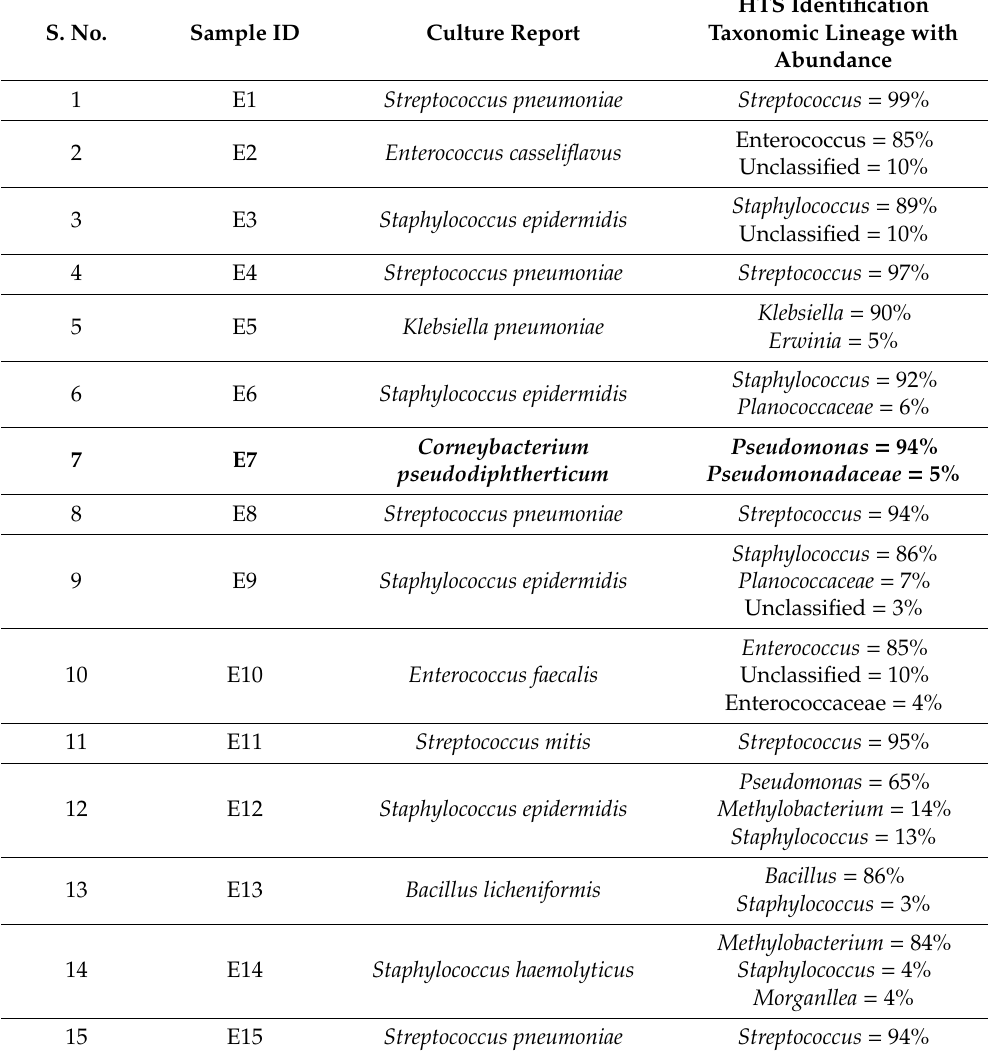
Table 2. High-throughput sequencing (HTS) reads and taxonomic classification of bacterial culture-positive samples.